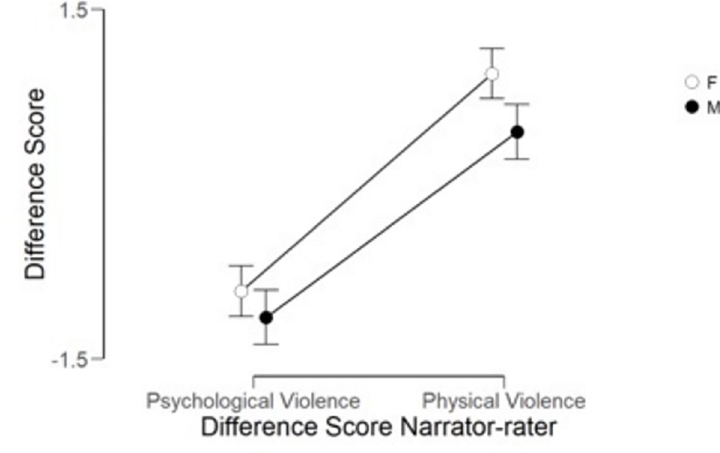
Fig 3. Difference score between severity ratings of violence for narrator and rater in Phase 2. F (hollow circle) stands for female and M (filled circle) for male gender, psychological violence is on the left side and physical on the right side. Bars show 95% confidence intervals.